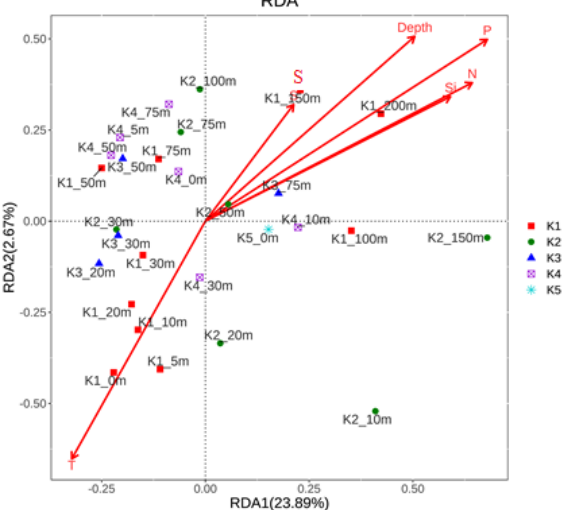
Figure 3. Relationships of small eukaryote community structure at different sampling sites with physiochemical factors in an ordination diagram with the first two axes of the Redundant Analysis (RDA). Red arrows with different lengths denote relative correlations of different independent variables with the community structure factors.